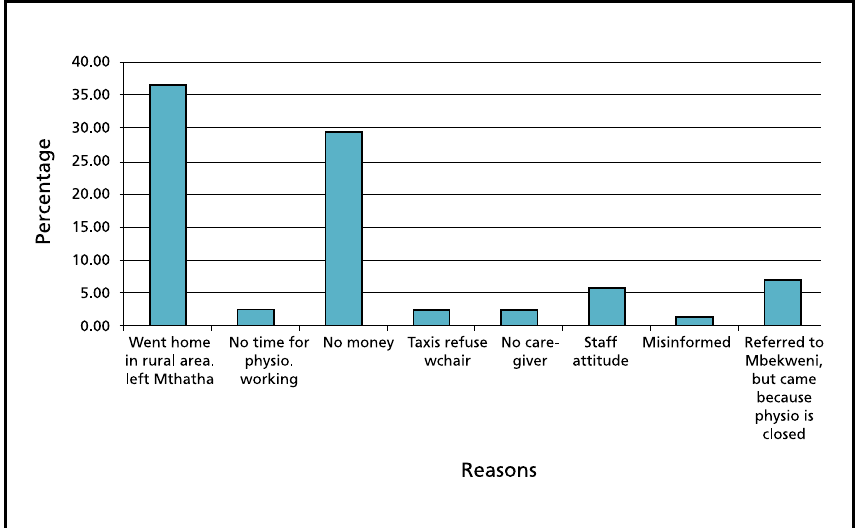
Figure 3: Reasons for poor attendance by patients with a stroke (n=73).